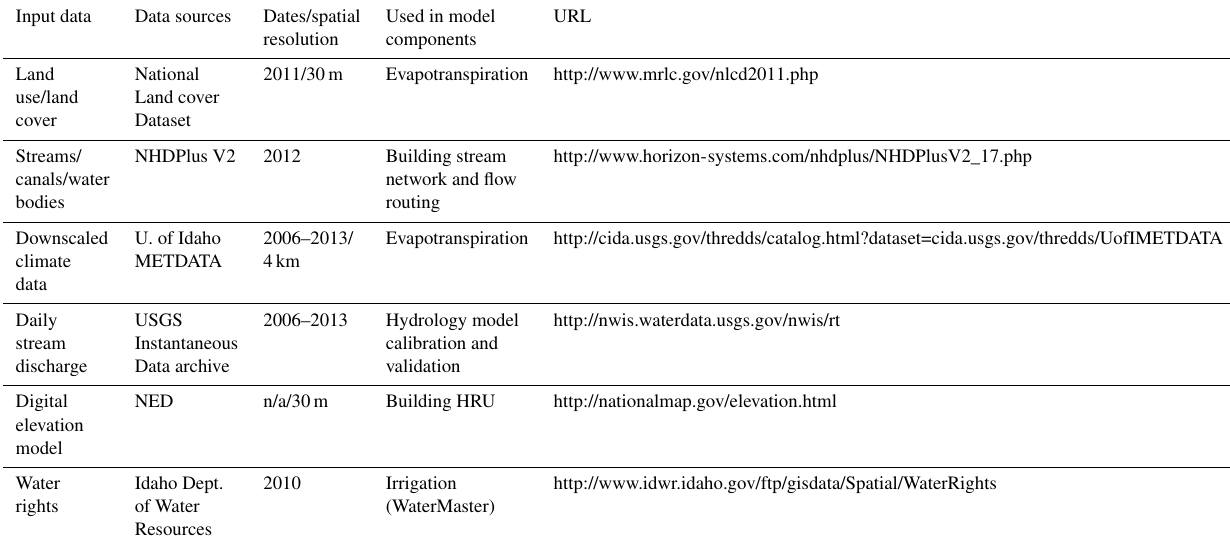
Table 1. Datasets used in the model.